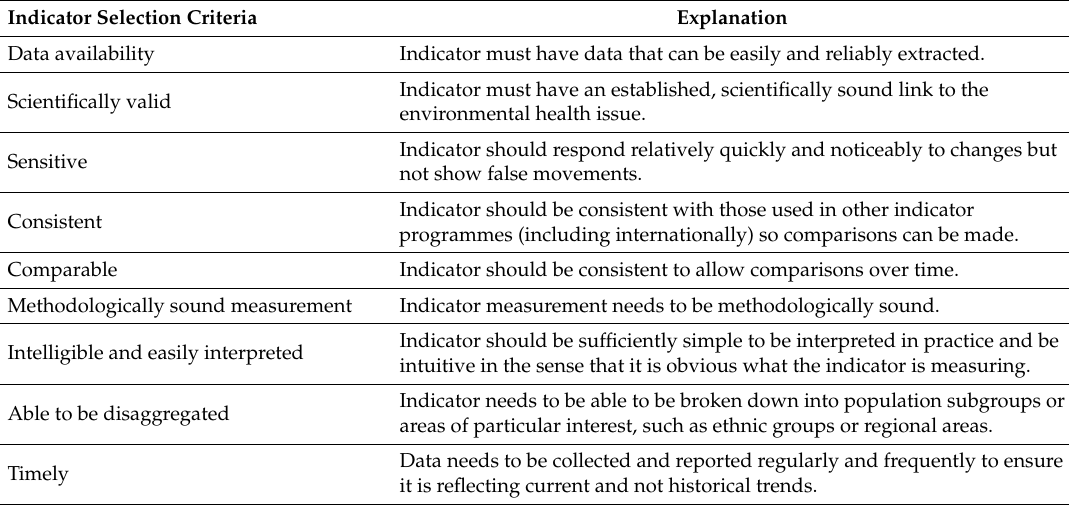
Table 1. Indicator selection criteria for New Zealand environmental health indicators.